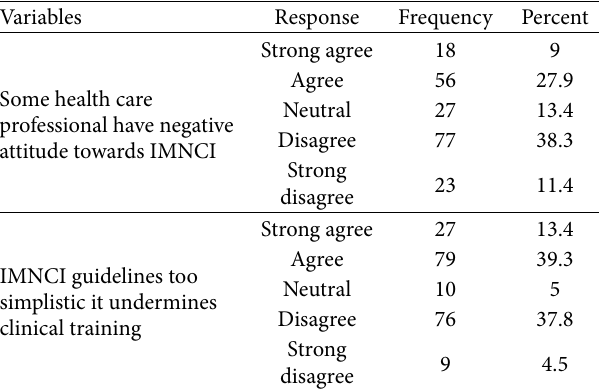
Table 15: Attitudes of health care professionals towards IMCI.